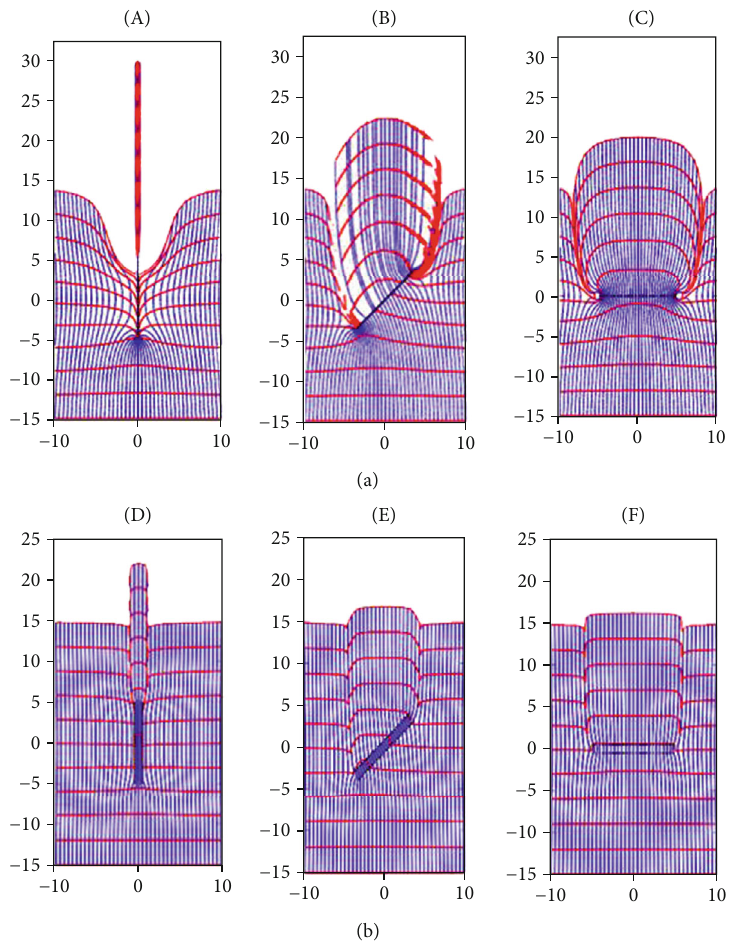
Figure 9: Particle paths (blue) and time-of- fl ight contours, spaced at 3 years (red) for cases shown in Figure